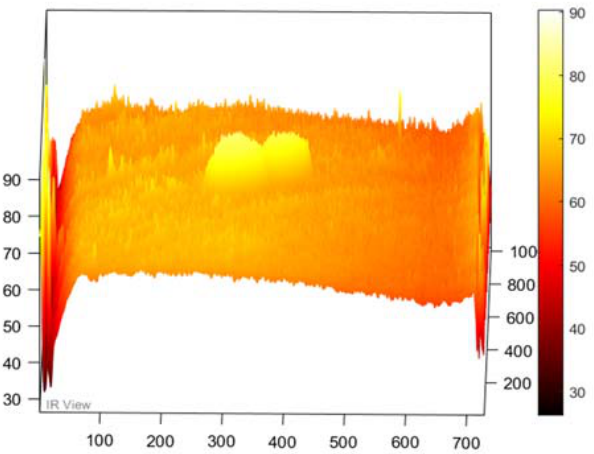
Figure 4. Three-dimensional image, corresponding to PPT.